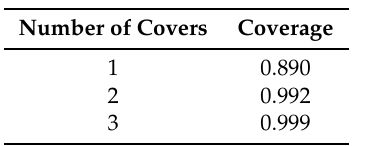
Table 7. Experiments on the maximum cover with a visibility